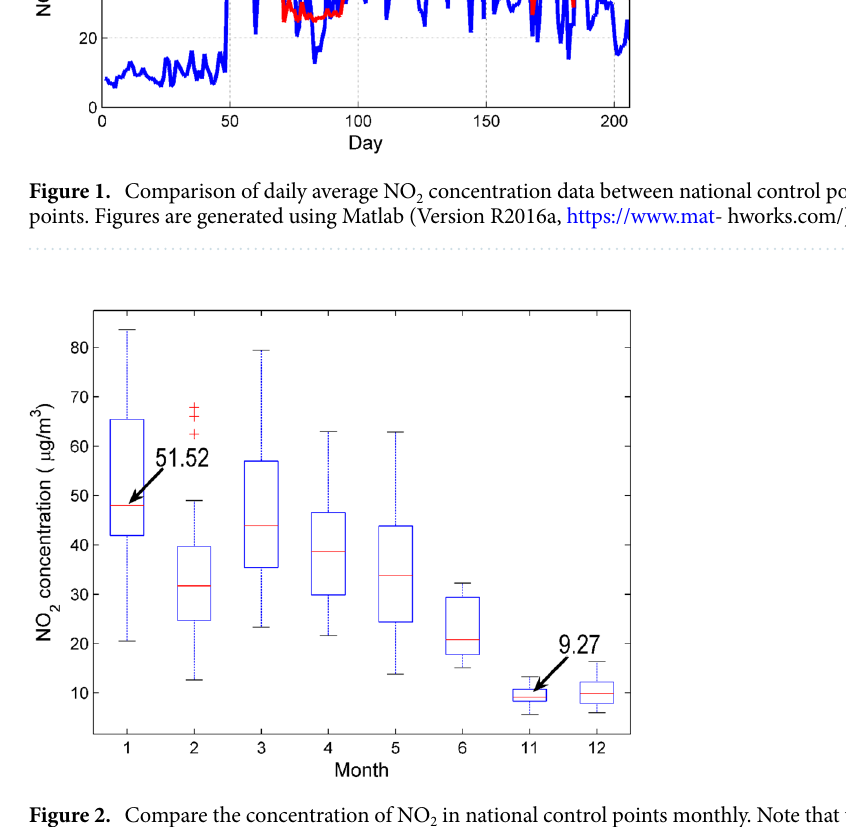
Figure 2. Compare the concentration of NO 2 in national control points monthly. Note that there is no data from July to October.